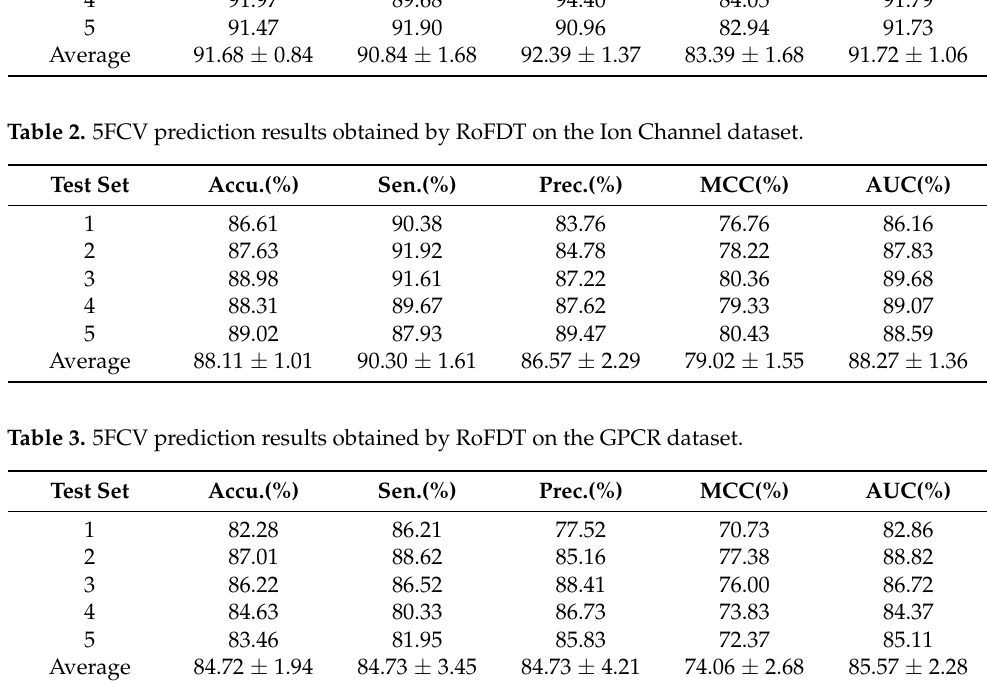
Table 1. 5FCV prediction results obtained by RoFDT on the Enzyme dataset.